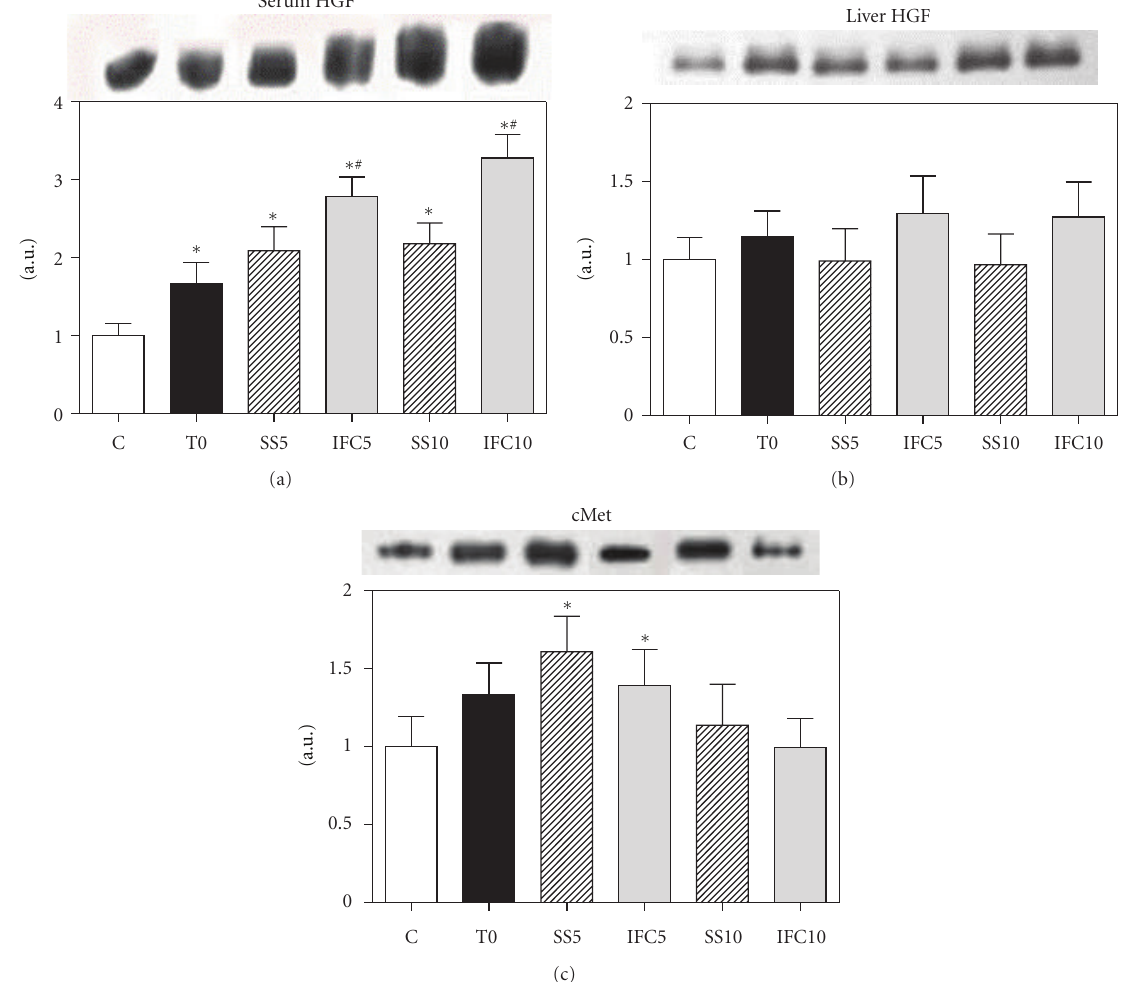
Figure 6: E ff ect of IFC305 treatment on serum HGF, liver HGF, and cMet proteins expression in CCl 4 -induced cirrhosis in rats. (a), (b), and (c) Expression of the indicated proteins from serum or liver extracts was done by western blot analysis. A representative western blot image of each one is shown. The bar graph represents the densitometry analysis expressed as arbitrary units of the mean ± SEM from 3rats/group; values were normalized to β -actin immunodetection (image, Figure 1(a)). Values from serum (a) were not normalized. ∗ Statistical di ff erence ( P < 0 . 05) when compared to C group. # Statistical di ff erence ( P < 0 . 05) when compared to their respective experimental group SS5 or SS10.